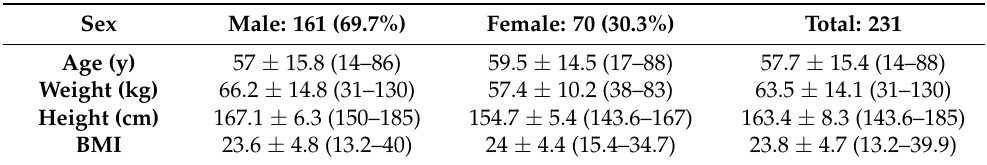
Table 2. Demographic Data. Values are given as number (%) and mean ± standard deviation (min-